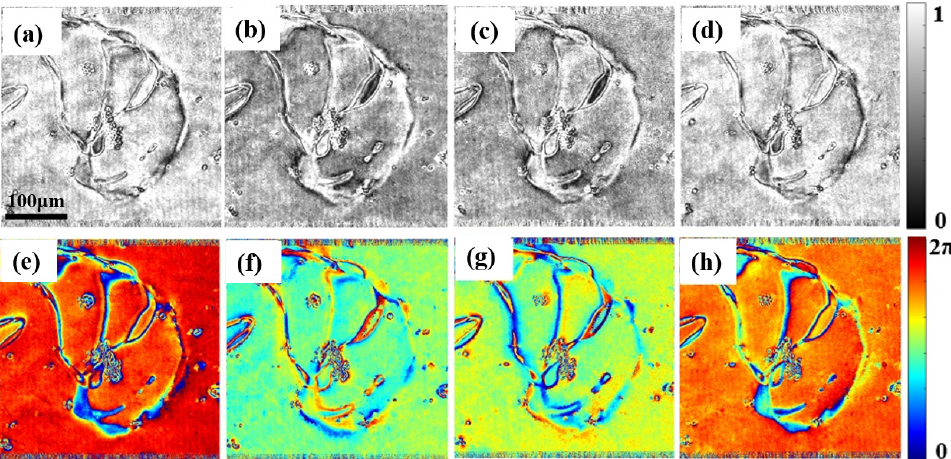
Figure 8. Amplitude and phase distribution of the Jones matrix of liquid crystal cell for an applied voltage of 4 V. ( a – d ) The amplitude distributions correspond to T tively; ( e – h ) are the corresponding phase distribution.